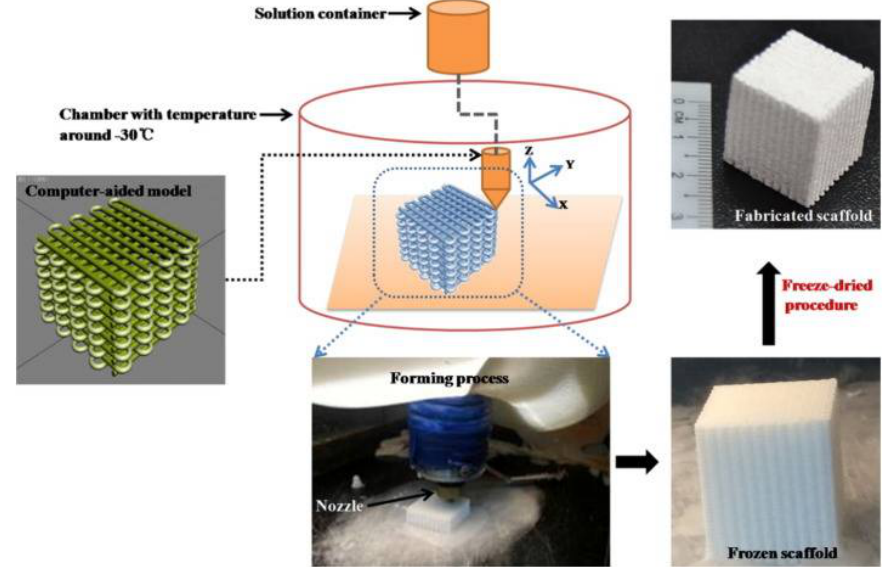
Figure 7. Schematic illustration of LDM 3D manufacturing of scaffold [67].